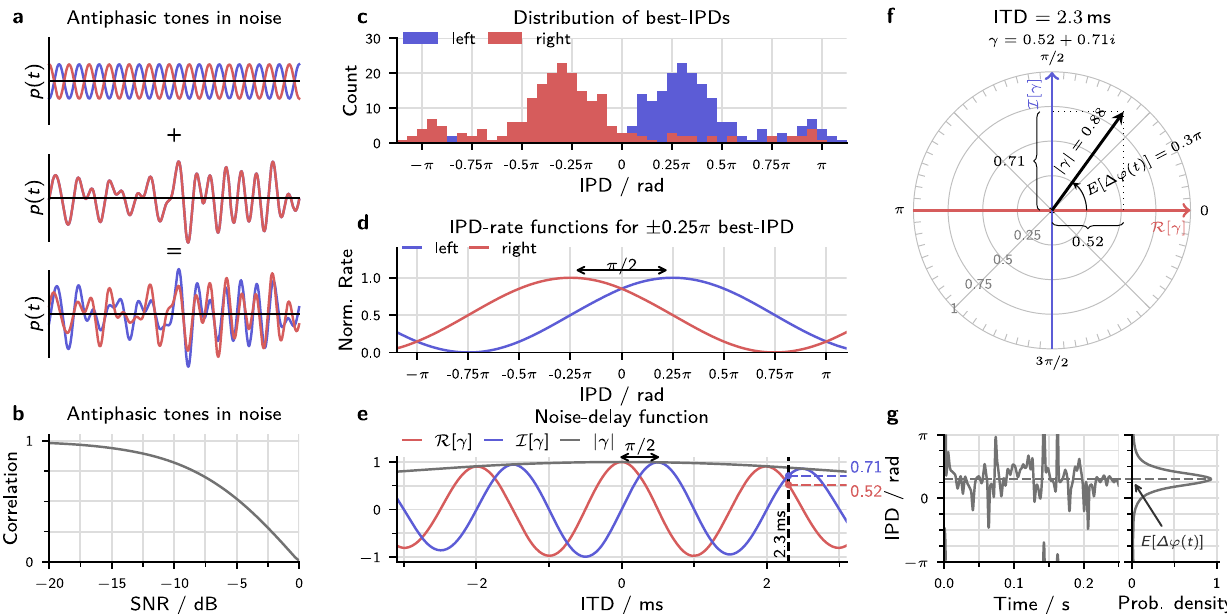
Fig. 1 Visualization of the modeling approach. a Schematic visualization of the signals in a tone-in-noise experiment. In this example, anti-phasic tones (top panel) are added to the same noise token (middle panel), resulting in a partly decorrelated stimulus (bottom panel). b The amount of decorrelation depends on the level of the added tone. This panel shows the correlation as a function of the signal-to-noise ratio (SNR) calculated for an anti-phasic tone- in-noise as visualized in a . c Histograms of the best-IPDs of 217 neurons that were digitized from 10 . For visualization, the histogram of the right hemisphere was added as an identical but mirrored version of the left hemisphere. d Assumed IPD-rate functions for two neurons with ± π /4 best-IPD. e Components of the complex-valued correlation coef fi cient for different ITDs. Results were calculated for Gaussian noise after applying a 500 Hz-centered gammatone fi lter with 79 Hz equivalent rectangular bandwidth. The real and imaginary parts of γ show the same π /2 phase shift as the IPD-rate functions in d . The dashed vertical line indicates an ITD of 2.3 ms with the two vertical lines indicating the associated values of the real and imaginary part. f Visualization of the different components of the complex correlation coef fi cient γ in the complex plane for the same noise and the 2.3 ms ITD indicated in e . g Instantaneous IPD Δ φ ( t ) for the same noise as used in e and f . The right subplot shows the corresponding probability density function 26 . The expected value of this distribution equals the argument of the stimulus coherence E ½ Δ φ ð t Þ(cid:2) ¼ arg ð γ Þ ¼ 0 : 3 π